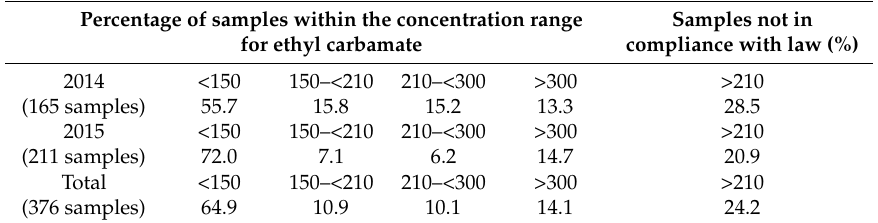
Table 2. Percentage of samples of cachaça within the concentration ranges for ethyl carbamate ( µ g/L). Percentage of samples within the concentration range Samples not in for ethyl carbamate compliance with law (%)